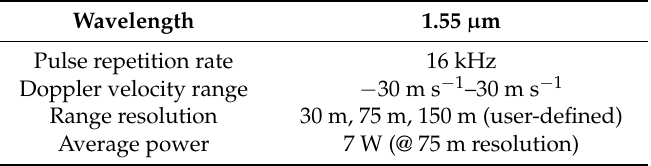
Table 1. Instrument specifications of the scanning Doppler light detection and ranging (lidar,